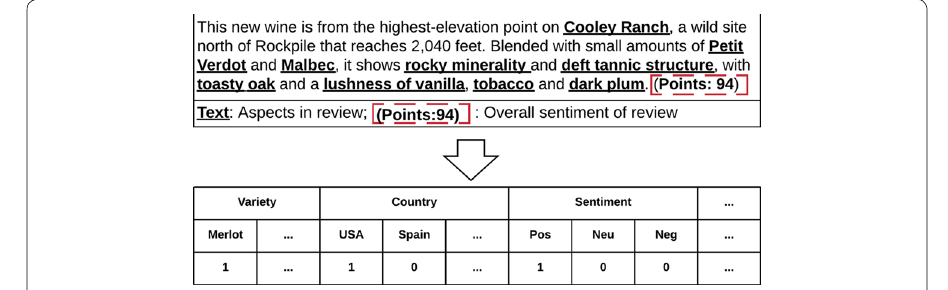
Fig. 1 An example of Aspect Enhanced Sentiment